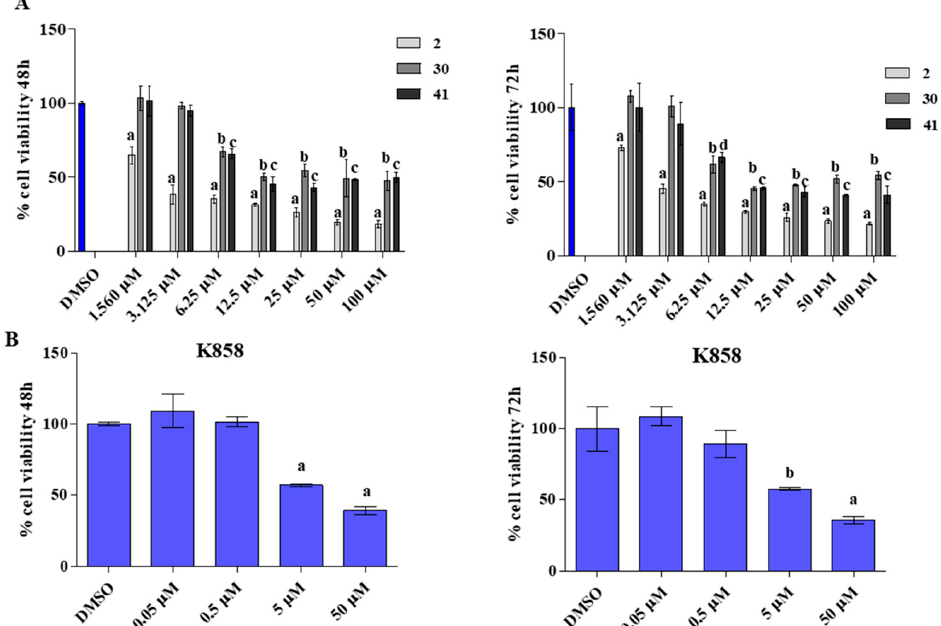
Figure 3. MTT test on MCF7 cells exposed to different concentrations of 2 , 41 , 30 ( A ) and to different concentrations of K858 ( B ) for 48 and 72 h. Metabolic activity was normalized with DMSO-treated cells (0.2% as final concentration). DMSO: control vehicle. Data shown represent the mean ± SD of three independent experiments. ( A ) a = p < 0.0001 DMSO vs. and all tested concentration of 2 at both time points; b = p < 0.0001 DMSO vs. doses from 6.25 µ M to 100 µ M of 30 at both time points; c = p < 0.0001 DMSO vs. doses from 6.25 µ M to 100 µ M of 41 at 48 h; c = p < 0.0001 DMSO vs. doses from 12.5 µ M to 100 µ M of 41 at 72 h; d = p < 0.01 DMSO vs. 6.25 µ M of 41 at 48 h. ( B ) a = p < 0.0001 DMSO vs. 5 µ M–50 µ M of K858 at 48 h; a = p < 0.0001 DMSO vs. 5 µ M of K858 at 72 h; b = p < 0.001 DMSO vs. 5 µ M of K858 at 72